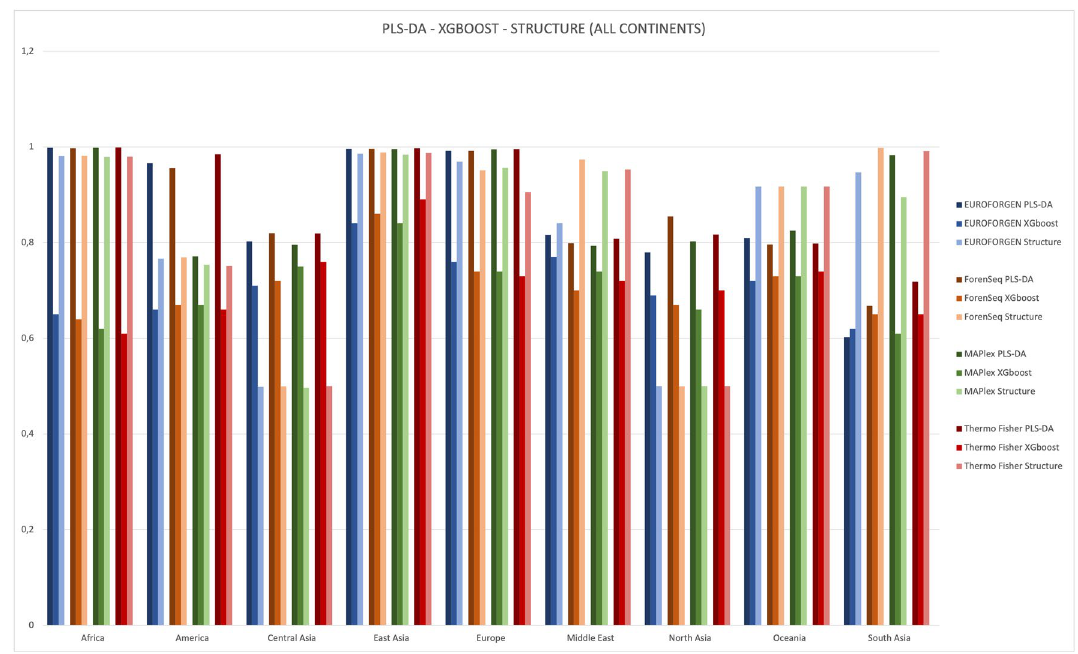
Figure 5. Comparison of AUC values of different populations obtained from PLS-DA, XGBoost, and STRU CTU RE at inter-continental level considering Asian divided into